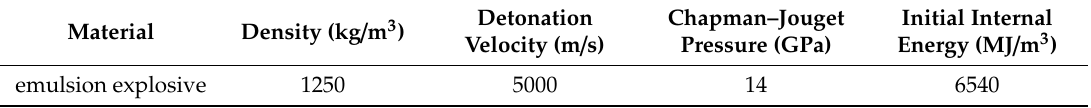
Table 1. Emulsion explosive